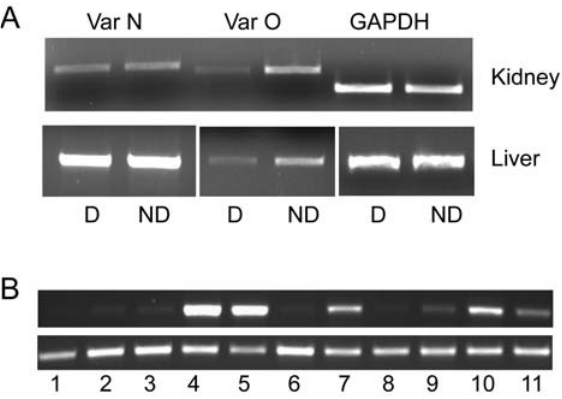
Figure 4. Tissue and isoform expression of canine SLC2A9. (A) Tissue expression by RT-PCR of canine SLC2A9 variant O, variant N, and GAPDH. D is liver and kidney RNA isolated from a Dalmatian, and ND is from a Newfoundland 6 Border Collie cross. (B) Tissue expression by RT- PCR of canine SLC2A9 on top and the GAPDH control on the bottom. Tissue samples from left to right are: 1 cerebellum, 2 cerebral cortex, 3 heart, 4 kidney, 5 liver, 6 skeletal muscle, 7 skin, 8 spinal cord, 9 spleen, 10 testis, 11